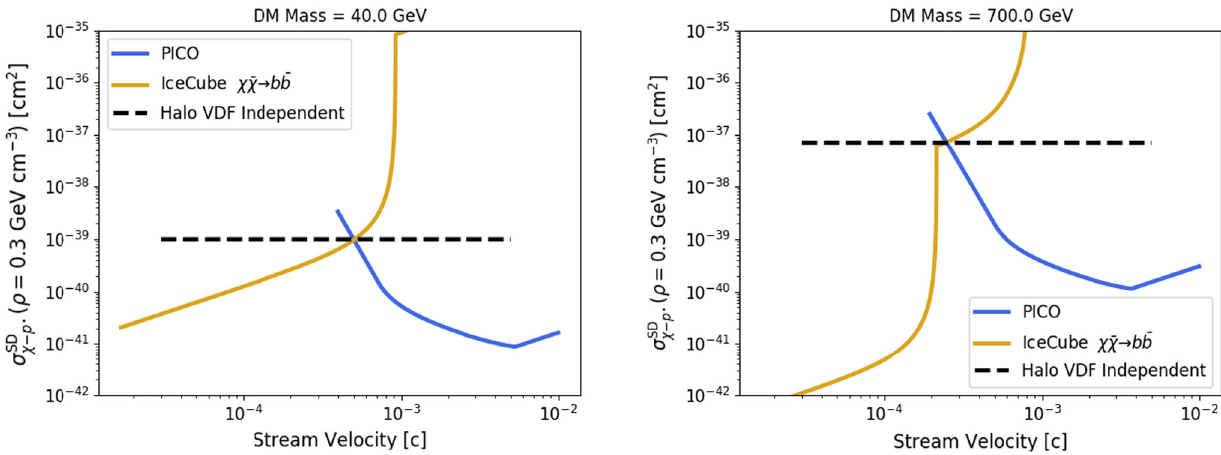
Fig. 1 Constraints at (cid:3) 90% CL on the spin-dependent DM-proton scattering cross-section from both IceCube and PICO for different val- ues of | v 0 | , for 40 (700) GeV WIMPs annihilating to b ¯ b are shown on the left (right). For 40 GeV WIMPs, as the efficiency of PICO falls off Fig. 2 DM velocity distribution independent constraints on the SD DM-nucleon interaction cross-section (cid:3) 90% CL. Systematic uncertainties are presented as shaded regions. The traditional SHM upper limits at 90% CL from IceCube and PICO are shown as dashed and dash dotted lines. The kinks in the constraints at ∼ 250 GeV (for W + W − and τ + τ − ) and ∼ 700 GeV (for b ¯ b ) are explained in Section